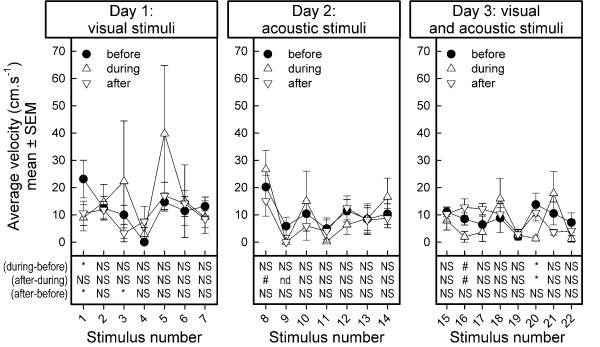
Average velocity before, during, and after stimulus presentation in 5 dairy goats. Velocity is depicted as mean ± SEM. Results of one-sample t-statistics on the difference scores between values during minus before, after minus during, and after minus before stimulus presentation are summarized in the lower part of the figures. The list of stimuli presented is shown in Table 1. NS: no effect, p > 0.10; nd: not determined, because all observations are zero-values, i.e. no goat was moving during a observation period; #: marginal effect, 0.10 > p > 0.05; *: effect, p < 0.05